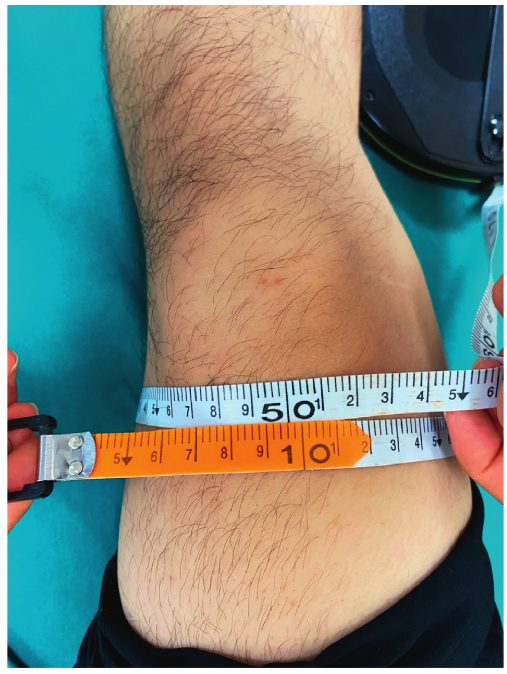
Figure 2: Therapist measuring the circumference of the patient’s injured